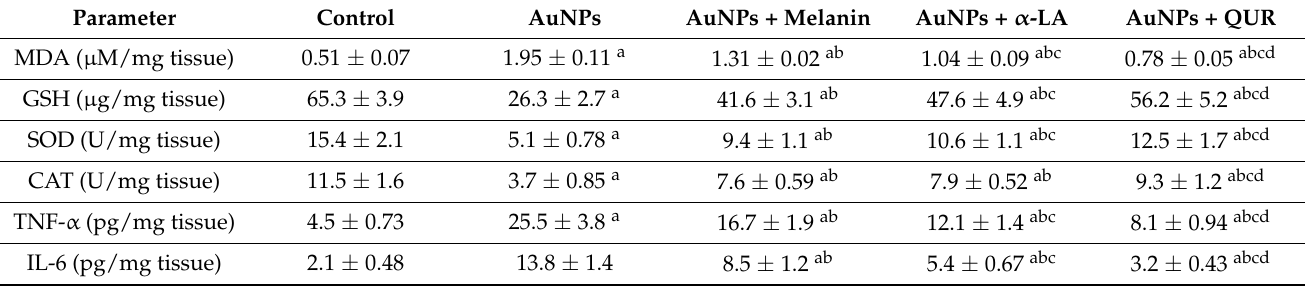
Table 2. Effects of the individual or combined treatments with gold nanoparticles (AuNPs) and selected drugs on selected markers of oxidative stress and inflammation in the livers of all experimental